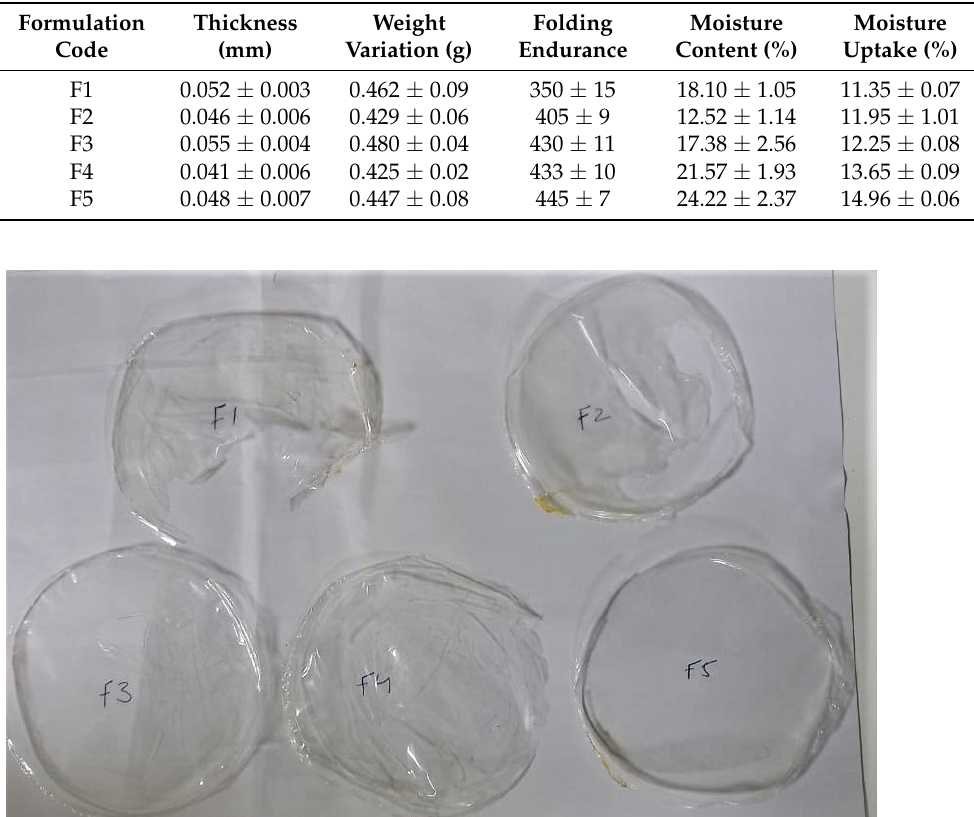
Figure 1. Pictorial Representation of various hydrogel films F1–F5. Table 1. Results of Physicochemical evaluation of hydrogel films. ( n =